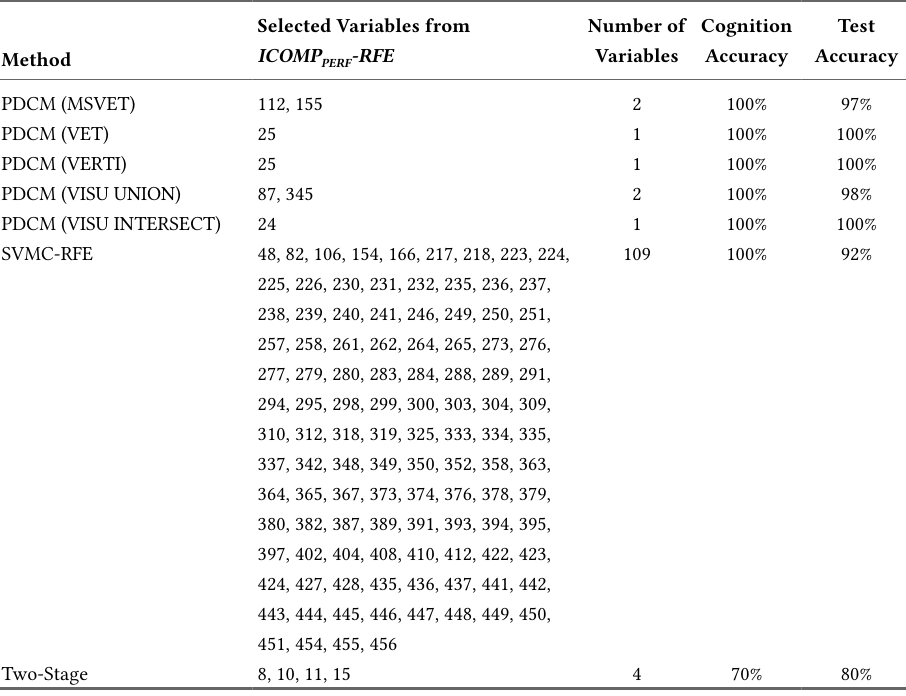
PDCM Versus Various Ranking Based Method Using Inverse Multi-Quadratic Kernel